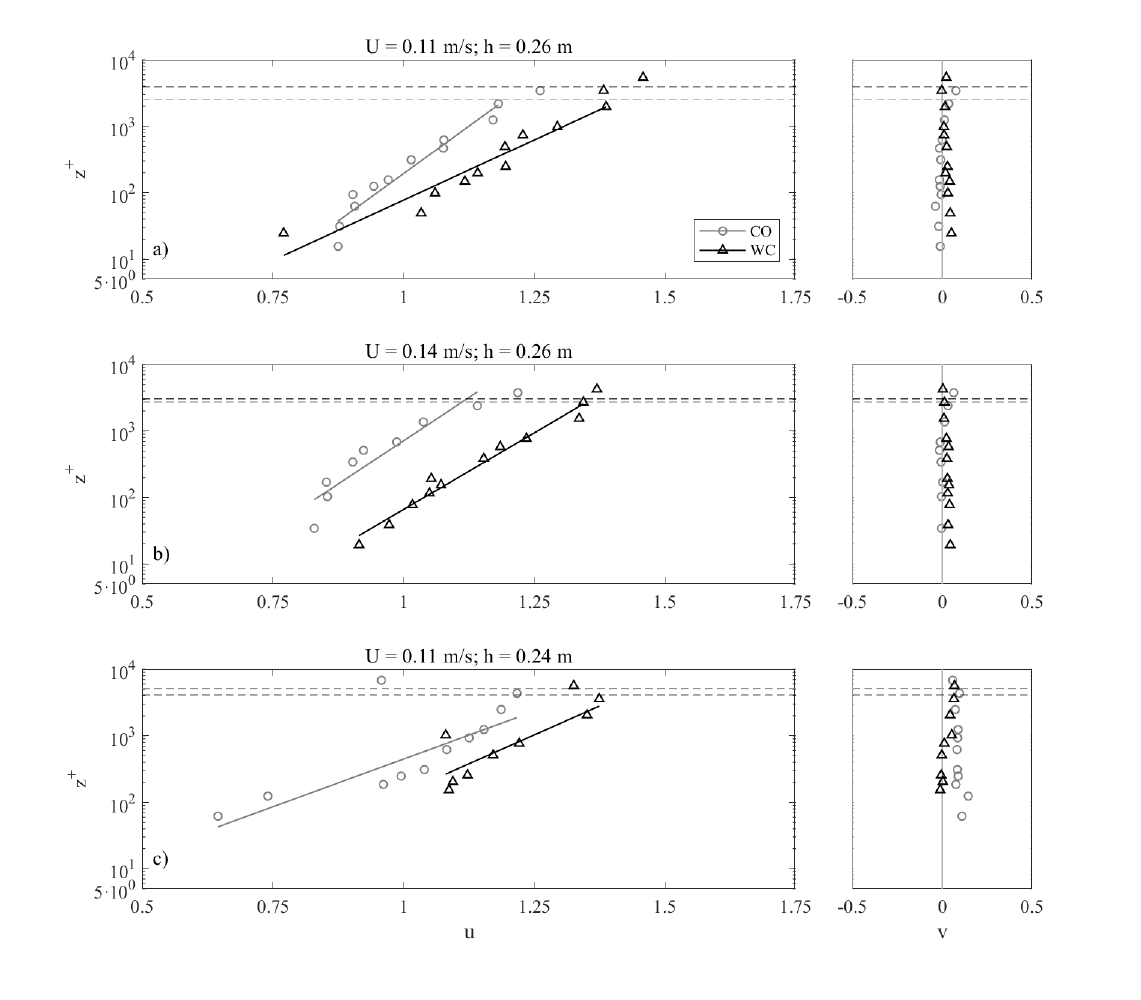
Figure 7. Dimensionless time-averaged logarithmic velocity profiles in the streamwise and crosswise direction: ( a ) tests 2 (CO) and 8 (WC) at CC with U = 0.11 m/s; ( b ) tests 3 (CO) and 9 (WC) at CC with U = 0.14 m/s; ( c ) tests 6 (CO) and 12 (WC) at SH with U = 0.11 m/s. All the tests are at CC ( x = 2.50 m, y = 1.00 h = 0.26 m). Dashed lines indicate the current boundary layer thickness δ c for the CO (grey) and WC (black)